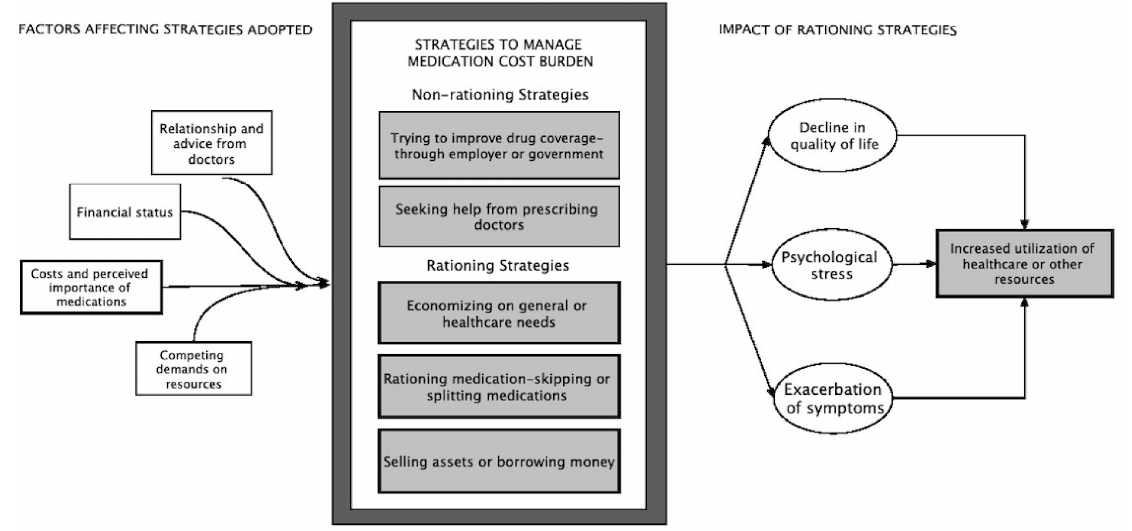
Figure 1. A conceptual model of patient approaches to manage medication cost